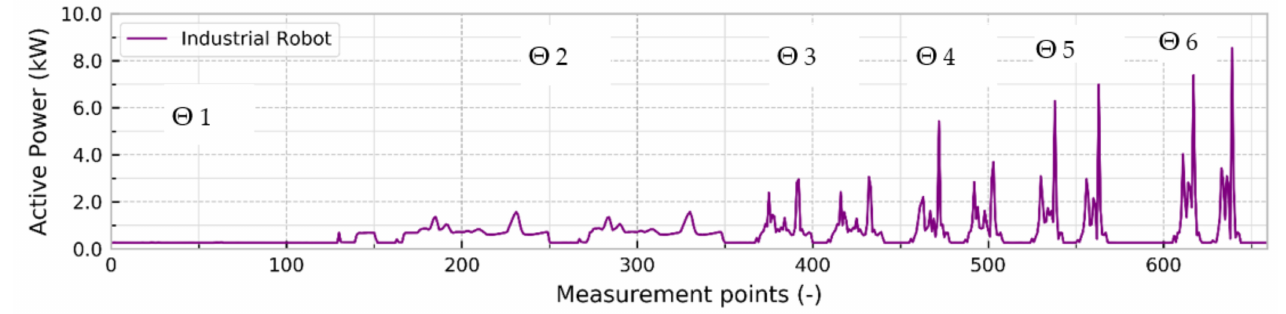
Figure 4. Time series of the sequence for the operation modes of Robot 1. During one mode, all movements of the robot are performed twice. The operation modes differ in speed. Faster movements require more power. Θ 1 is the ‘ standby ’ mode, in which the machine consumes only little power. Θ 0 resembles the ‘ off ’ mode, in which the machine is switched off and does not consume any power.